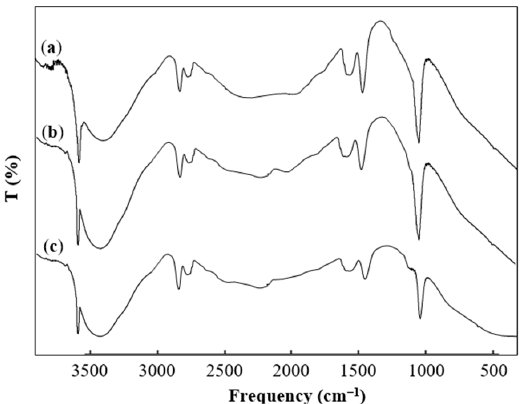
Figure 3. IR analysis of (a) Ca(OCH 3 ) 2 synthesized using conventional water-bath heating for 2 h and Ca(OCH 3 ) 2 synthesized using a homogenizer (b) 60 min and (c) 30 min.